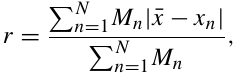
Table 3. Contingency table computed for rainy and dry days. Contingency